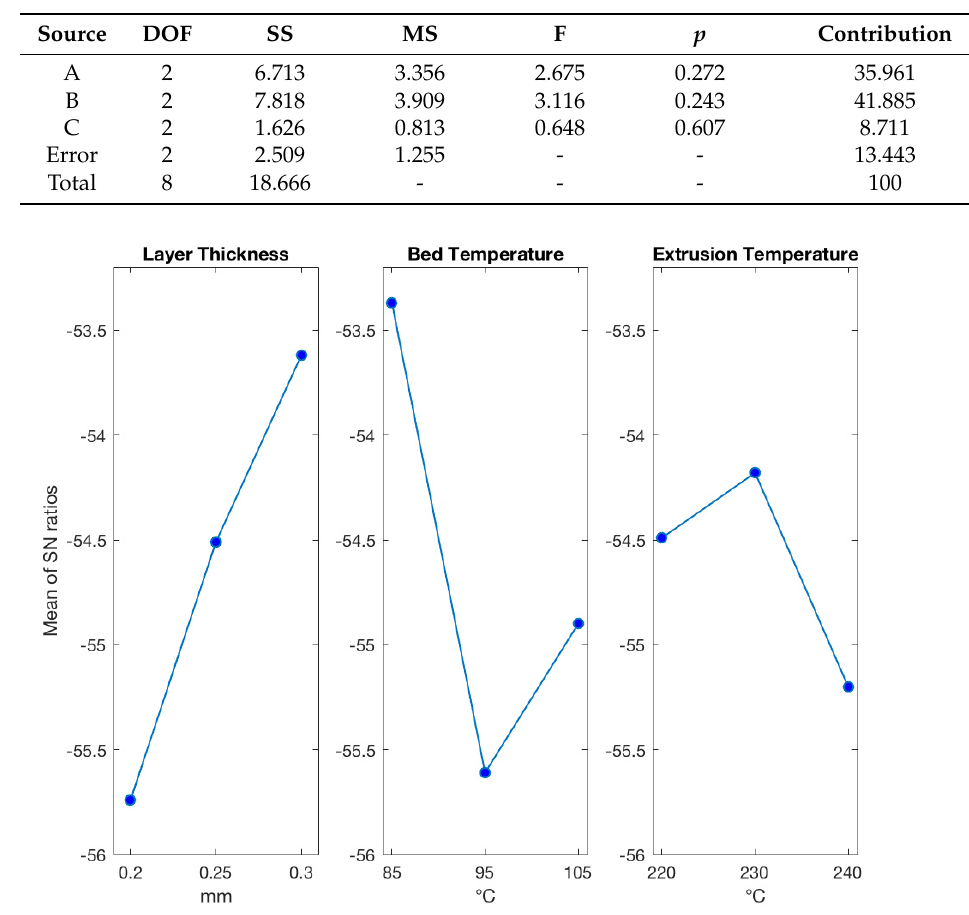
Table 8. ANOVA table for the warpage optimization based on experimental results.